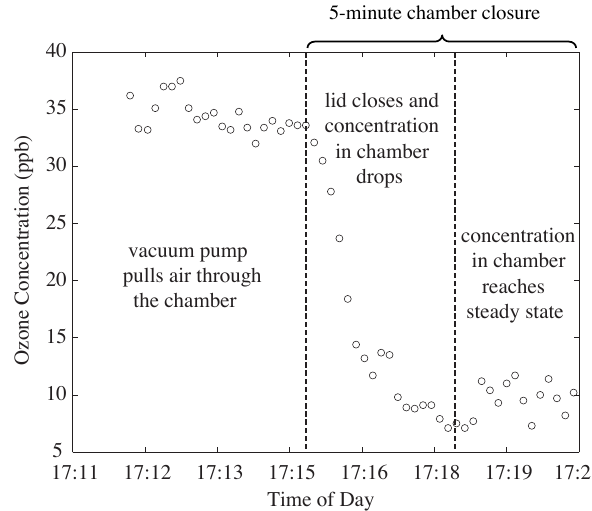
Figure 4. The plot above is an example of ozone data that can be analyzed using the steady-state mass-balance equation. The data be- fore the lid is closed and at the end of the sample both have low noise and stay relatively constant for at least